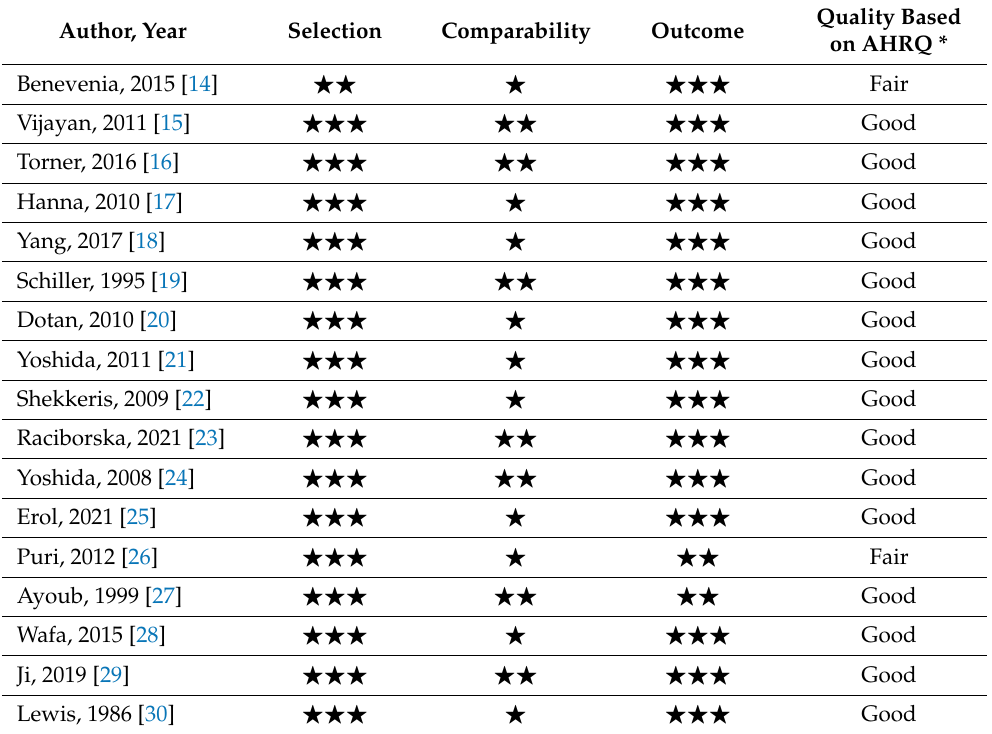
Table 1. Newcastle-Ottawa quality assessment of included studies. The maximum stars possible for the involved criteria are 1 in selection, 2 in comparability and 3 in outcome. * AHRQ: Agency for Healthcare Research and